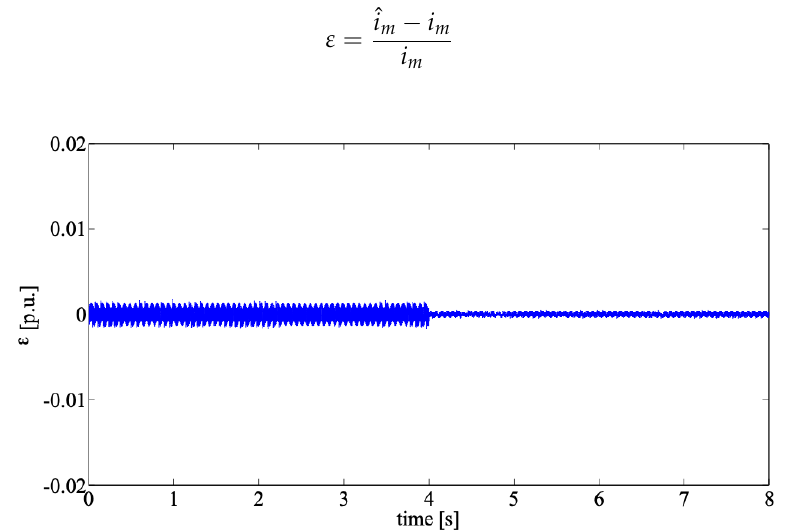
Figure 14. Error between the actual magnetizing current and the estimated current (case A).